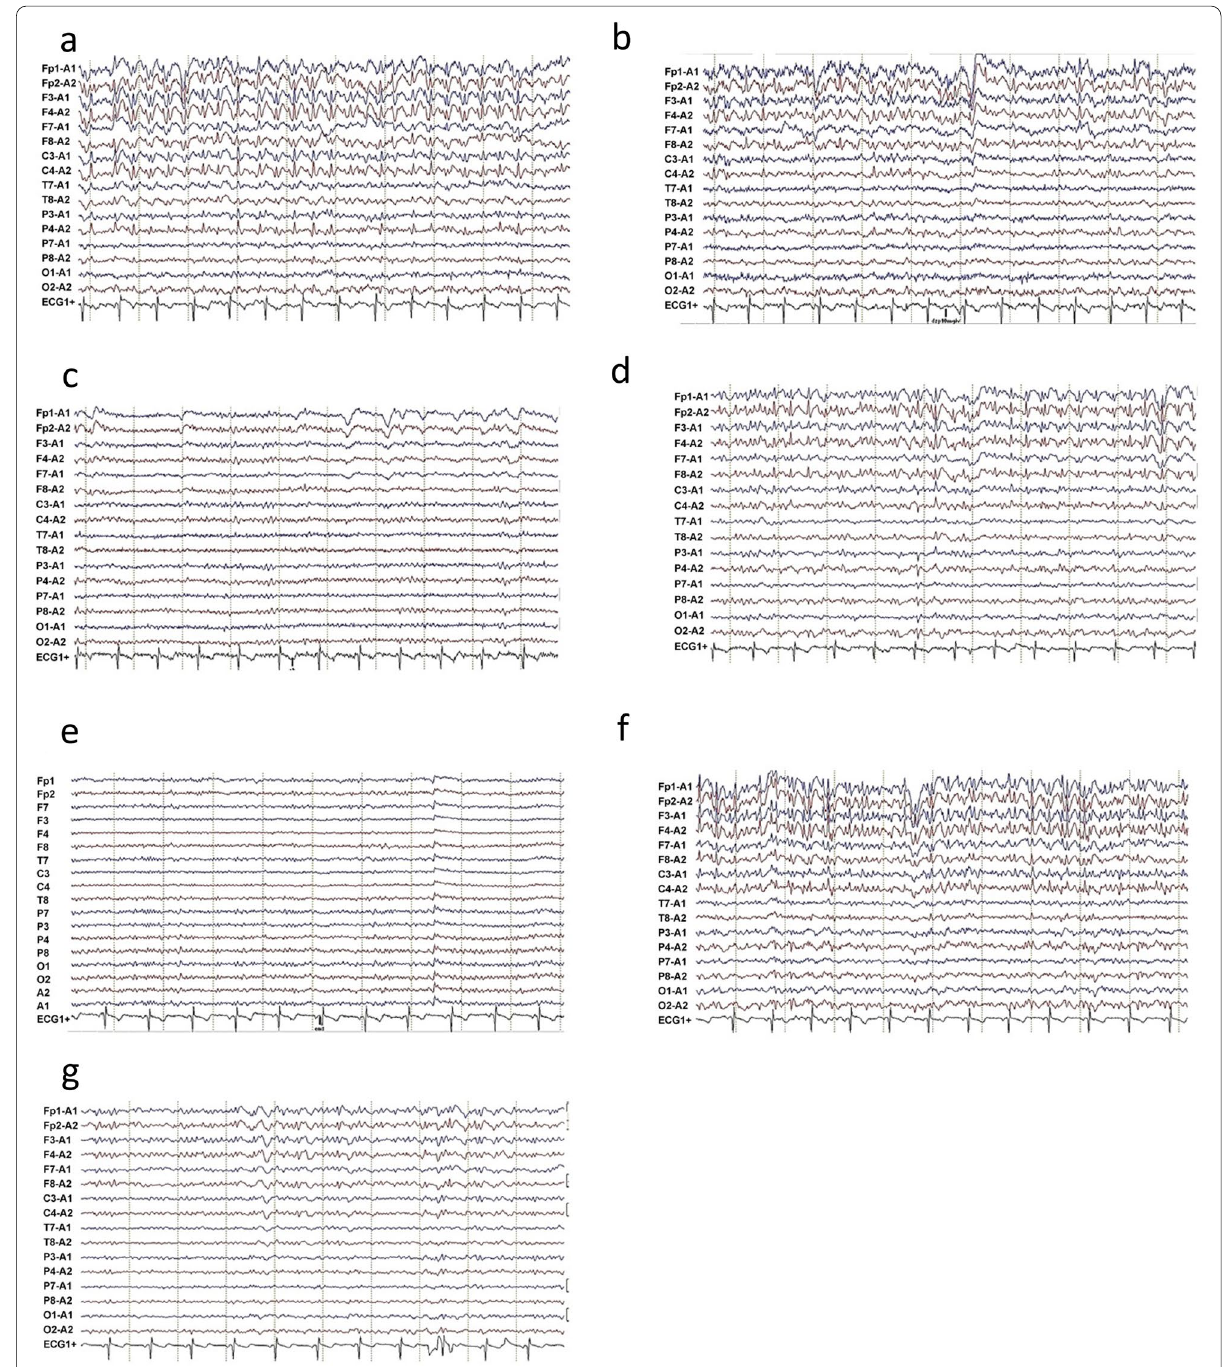
Fig. 1 EEG recordings of case 1. a 2.5- to 3.5-Hz generalized spike-and-wave discharges associated with symptoms of being confused, slow in speech and disoriented. b The EEG started to return to normal once the patient was given intravenous administration of 10 mg of diazepam. c Resolution of generalized spike and-wave pattern within 2 min after intravenous administration of 10 mg of diazepam. d Thirty minutes later, EEG showed 2.5- to 3-Hz spike-and-wave, spikes and slow waves with frontal and central predominance again. e Within 3 min after another 10 mg of diazepam, normal background EEG rhythms reappeared. f Although the EEG evolved into spike-and-wave pattern again, the patient became free from symptoms: being clear in consciousness, fluent in speech and capable of responding correctly. g The EEG returned to normal eventually with a total clinical